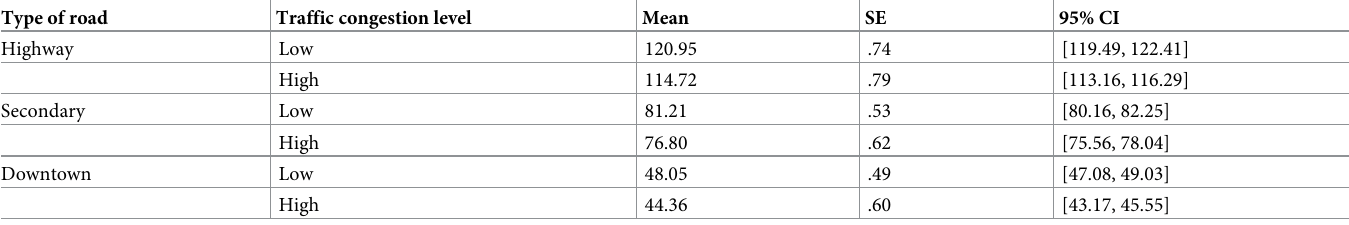
Table 5. Participants’ reported manual driving speed (in km/h) according to type of road × traffic congestion level. Type of